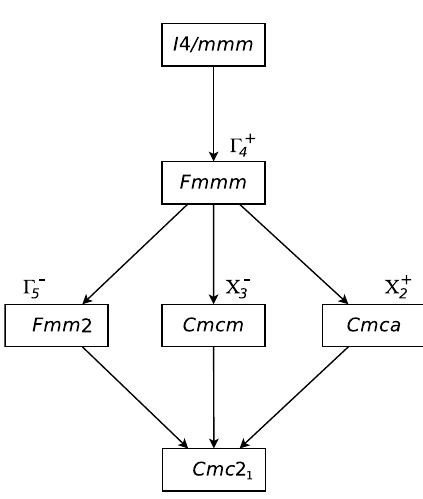
Figure 11. Graph of maximal subgroups connecting the space group I 4 /mmm and its subgroup C mc 2 1 (cid:9) (cid:10) c , a − b , a + b ; 1 , 1 ,0 (or equivalent). Note that the group C mca (N. 64) is labelled C mce in the new convention 4 4 of the 5th edition of the International Tables for Crystallography, Vol. A